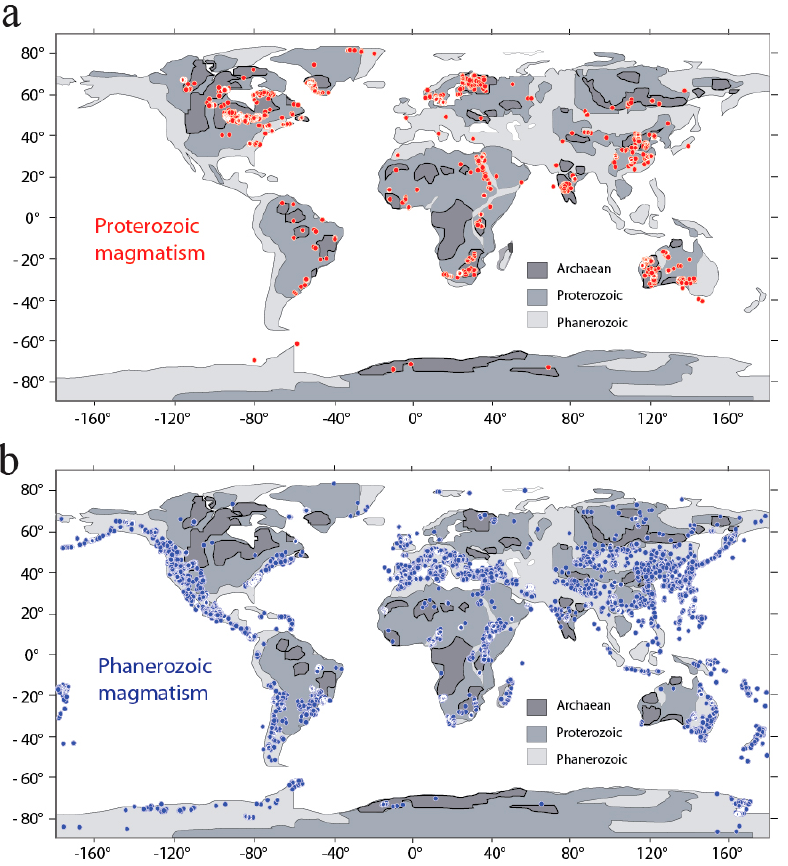
Figure 2. Distribution of Proterozoic ( a ) and Phanerozoic ( b ) magmatism on the Earth’s continental surface. The figure shows that Phanerozoic magmatism mostly occurs in lithosphere rimming Archaean and Proterozoic cratons and a concentric distribution of Proterozoic magma is also observed at the boundaries of Archaean nuclei, suggesting that most Precambrian lava considered in this study took place in arc settings.